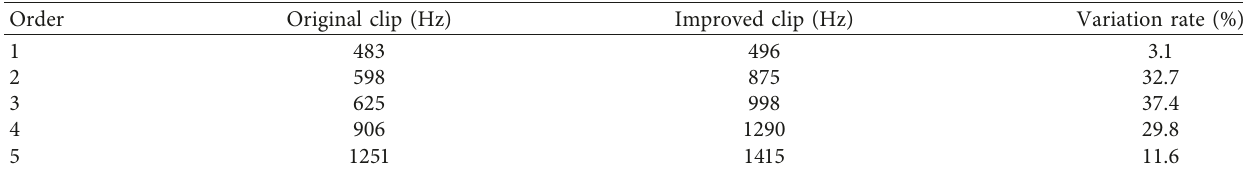
Figure 19: Original and improved ω -type rail clips in the test. Table 6: Modal frequencies of the original and improved rail